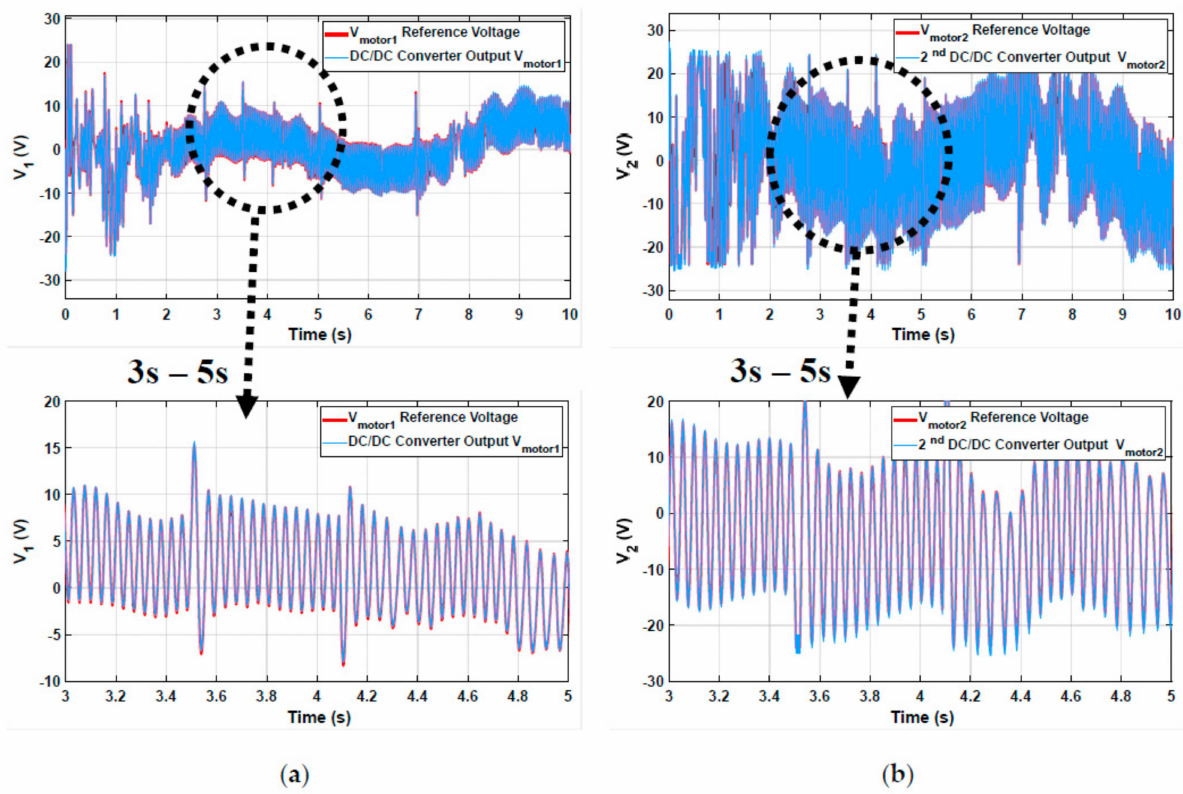
Figure 11. The comparison of the voltage-tracking performance of DC/DC converters ( a ) The reference and output voltage comparison for DC/DC converter 1. ( b ) The reference and output voltage comparison for DC/DC converter